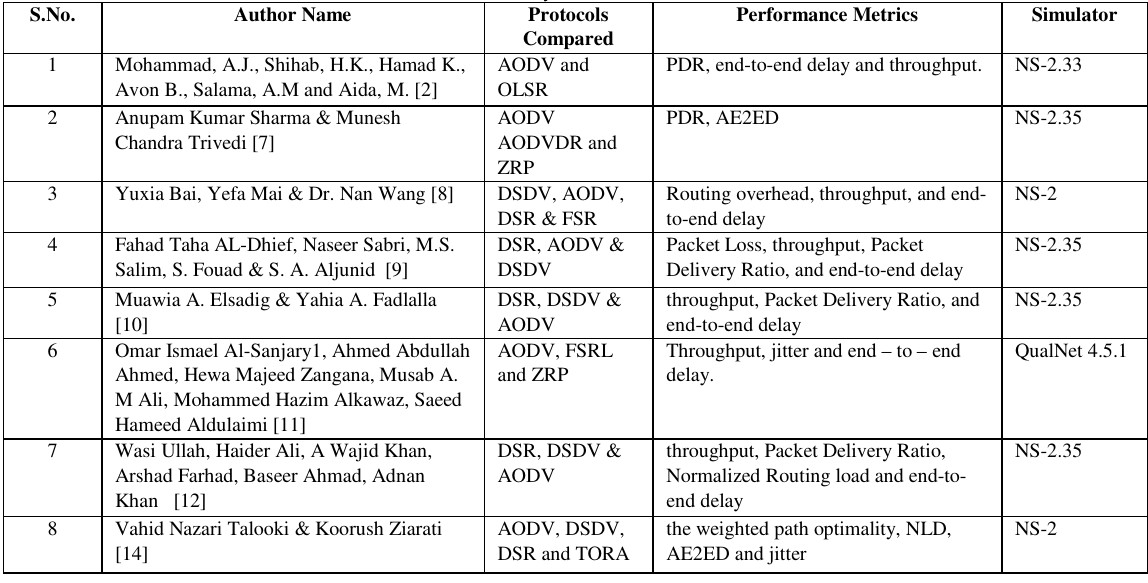
Table 1: Summary of Literature Review